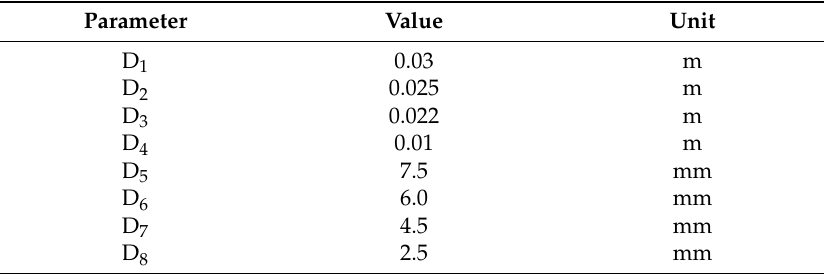
Table 2. Size parameters of the four layers.